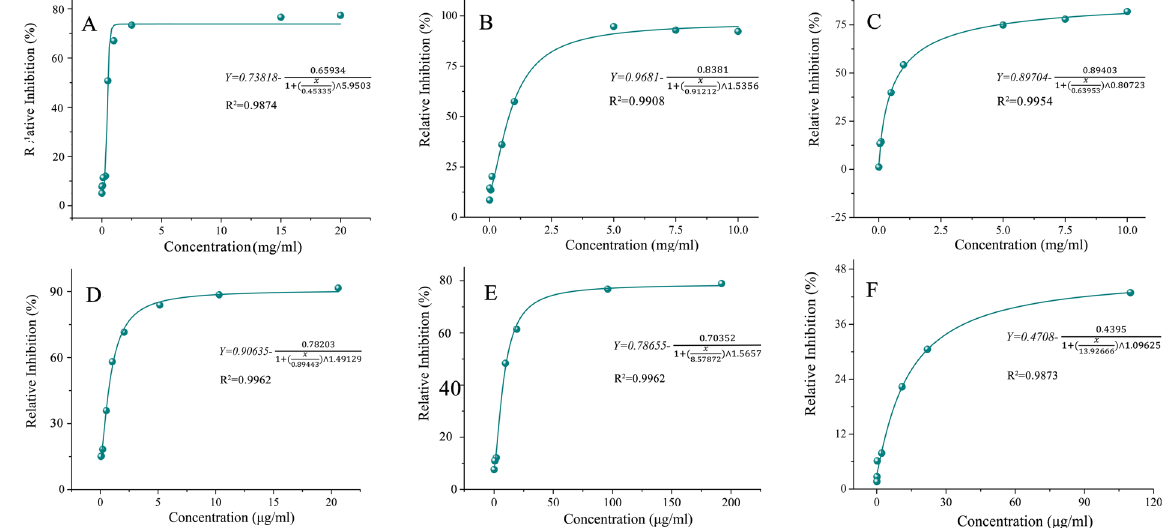
Figure 3. Concentration-COX-2 inhibition rate- curves of different Xiaojin Pills’ samples and three compounds. S4 ( A ), S1 ( B ), S6 ( C ), Pro ( D ), Bet ( E ) and Lev ( F